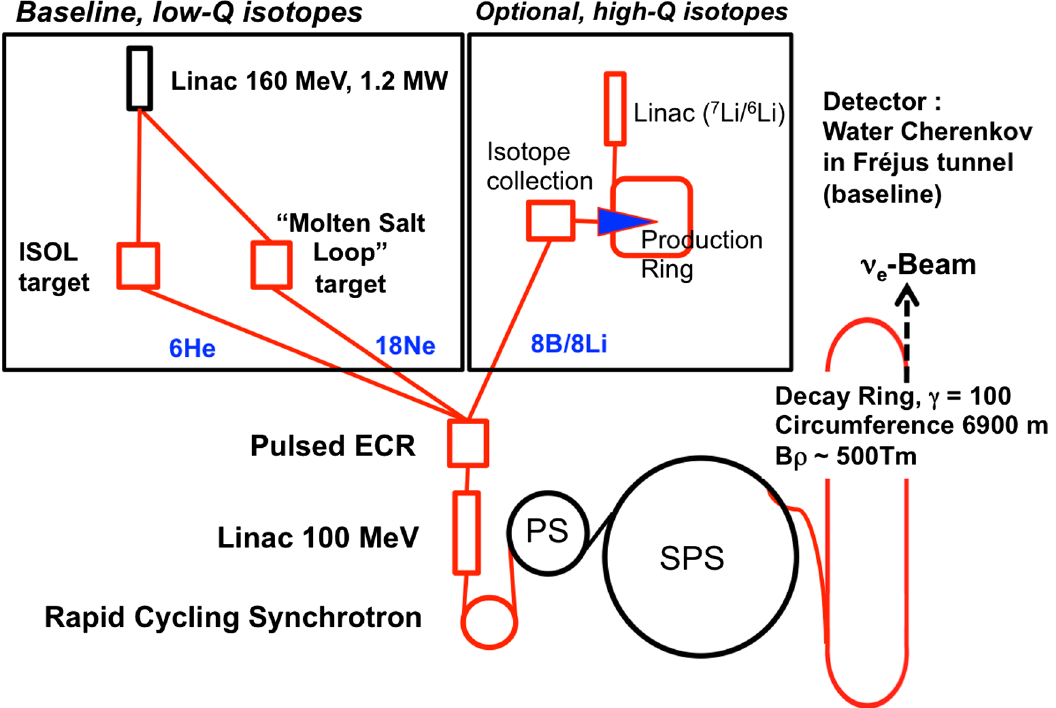
FIG. 14. Layout of the CERN Beta